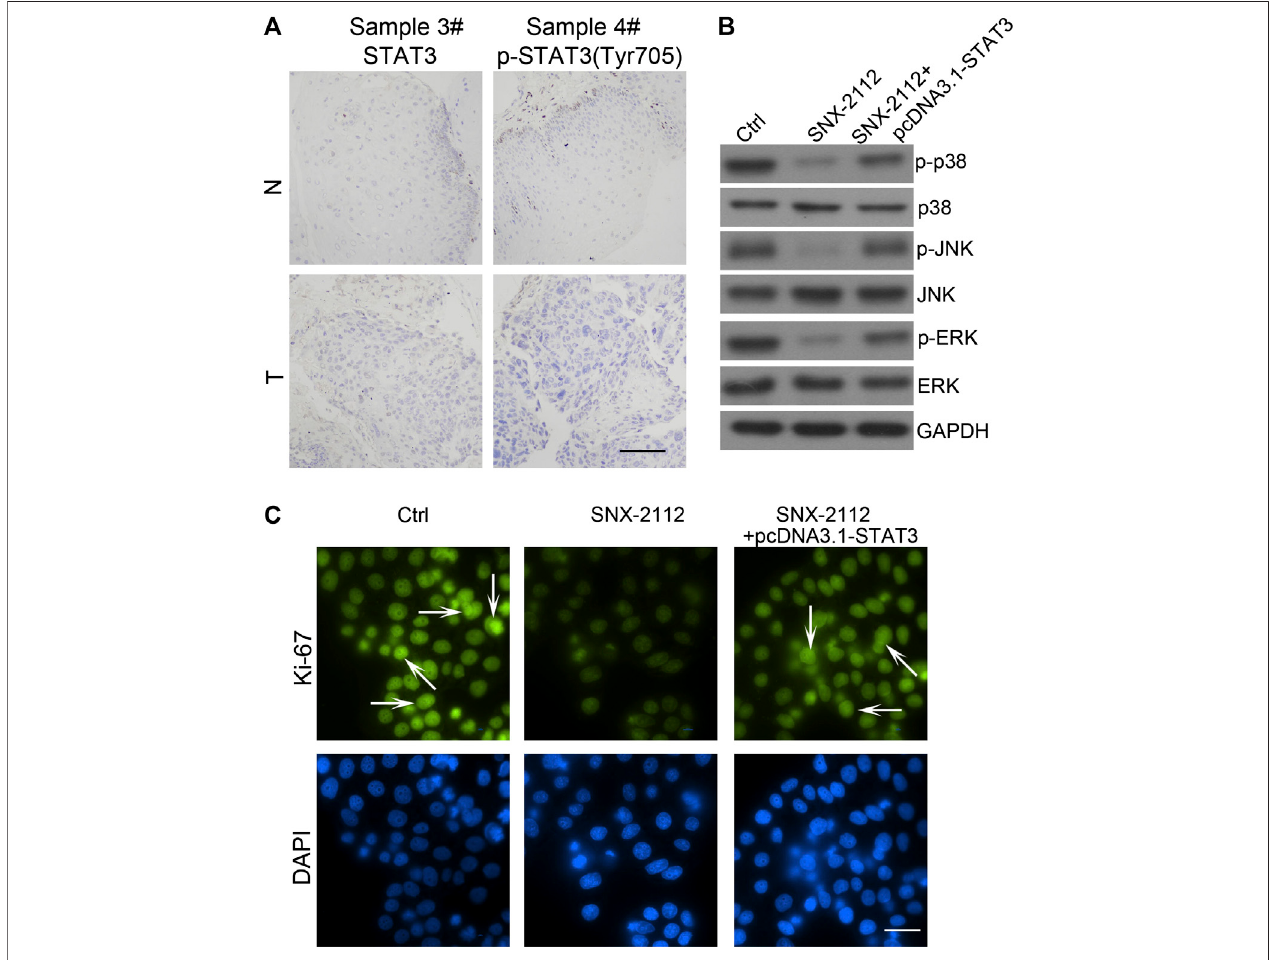
FIGURE 6 | STAT3 overexpression-reducing the ef fi cacy of SNX-2112 (A) STAT3 expression was analyzed in tumor specimens compared with adjacent normal tissue. Representative images of various clinical esophageal cancer specimen sections were present. T, tumor tissues; N, normal. Scale bar, 50 μ m. (B) Western blot analysisofp38,JNKandERKexpression. ECSLCsweretransfectedwithpcDNA3.1-STAT3vectorsfor72 handthen0.2 μ MSNX-2112for24 h.GAPDHwasusedas a loading control. (C) The proliferation analysis of ECSLCs treated with pcDNA3.1-STAT3 vectors for 72 h and then 0.2 μ M SNX-2112 for 24 h. The cells were collected and incubated with Ki-67 antibody. Scale bar, 50 μ